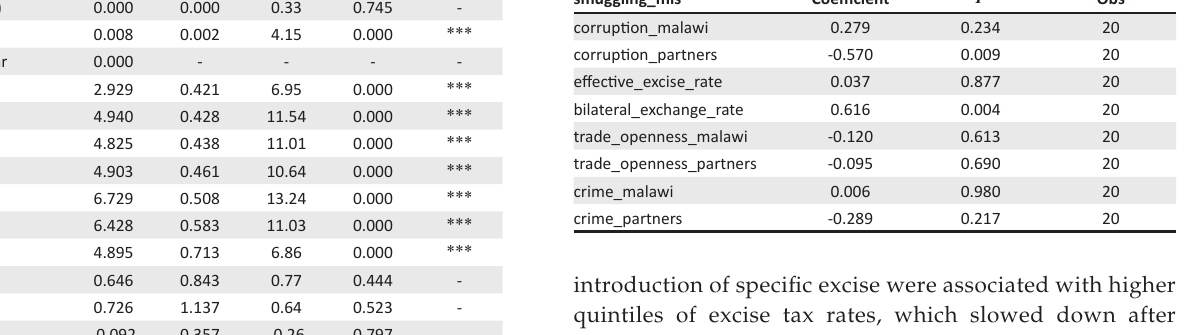
TABLE 3: Excise tax quintiles and years of cigarette imports regression results. Quintiles of excise tax Coef. SE t p Sig. NEWCIF (USD) CURRATE